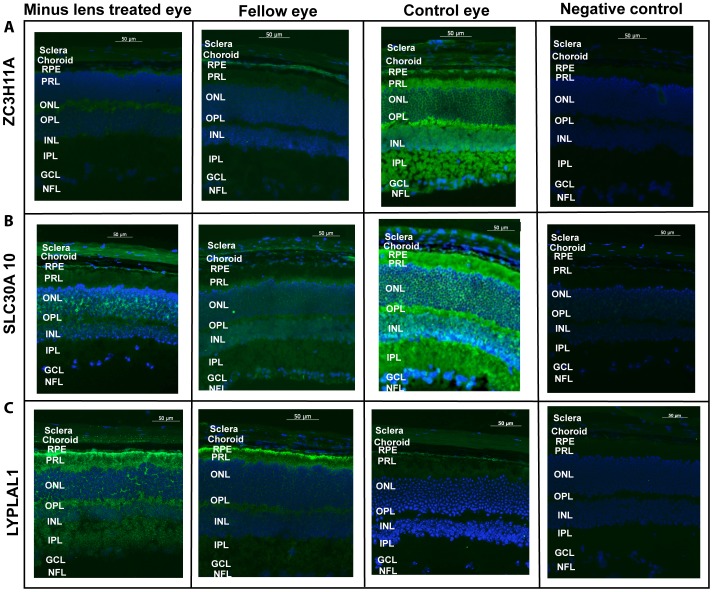
Immunofluorescent labeling.Immunofluorescent labeling of (A) ZC3H11A (B) SLC30A10 and (C) LYPLAL1 in mouse retina, retinal pigment epithelium and sclera in induced myopic eyes, fellow eyes and independent control eyes. The neural retina (retina), retinal pigment epithelium (PRE) and scleral cells were immunolabeled with the polycolonal antibodies against ZC3H11A, SLC30A10 and LYPLAL1 and were co-labeled with 4′,6-diamidino-2-phenylindole (DAPI). Negative controls were devoid of a fluorescence signal, treated with the secondary antibody alone and DAPI. No immunostaining was observed in the negative controls. Scale bar represents 50 µM and magnification is 200×. The florescence intensity labeled of the green color shows the localization of proteins and blue color indicates the nuclei that were stained with DAPI. Expression of the proteins had a trend in abundance similarly to that of their mRNA levels as depicted in Figure 4. Lower level of expression was determined for ZC3H11A in all tissues for myopic mice. Similarly significant reduction was shown in the expression of SLC30A10 in retina and RPE while higher level of expression was found in myopic sclera. LYPLAL1 showed higher level of expression in the retina and RPE tissue but reduced expression in the sclera in myopic mice. The following abbreviations represent the retinal layers: nerve fibre layer (NFL), ganglion cell layer (GCL), inner plexiform layer (IPL), inner nuclear layer (INL), outer plexiform layer (OPL), outer nuclear layer (ONL), photo receptor layer (PRL) and retinal pigment epithelium (RPE).